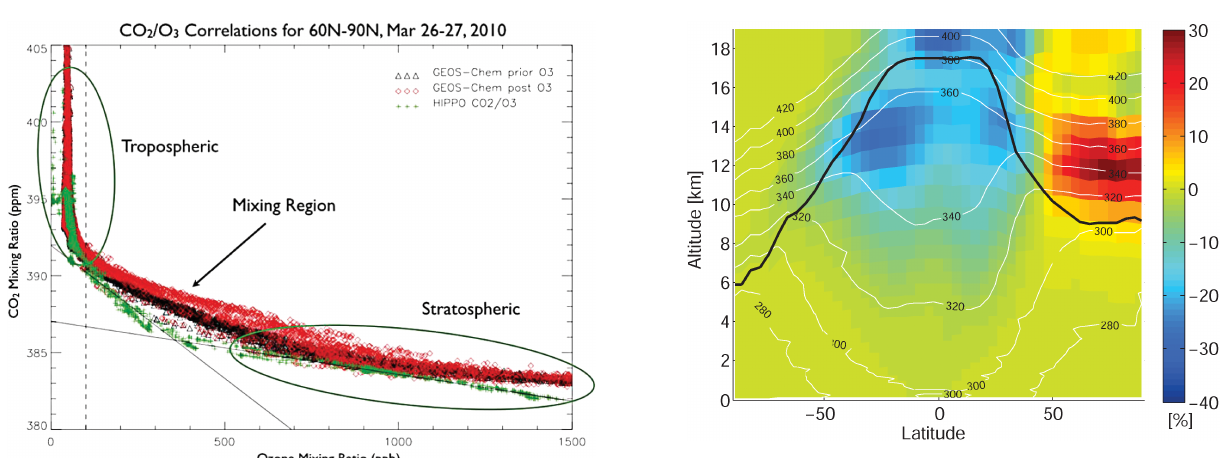
Figure 4. Zonal mean change in the GEOS-Chem O 3 distribution as a result of the assimilation of OSIRIS O 3 data. The assimilation was conducted for 20 March–2 April 2010. As in Fig. 1, the white lines indicate the zonal mean potential temperature in Kelvins (K) and the thick black line denotes the location of the tropopause in the